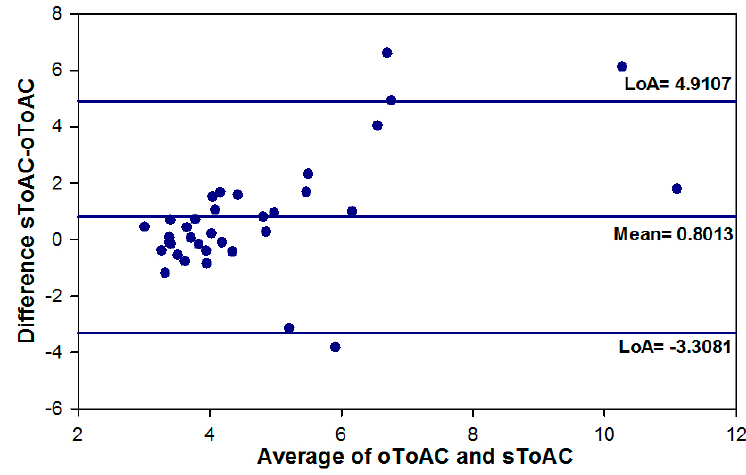
Figure 8. Bland and Altman plot of Subjective Time for Accommodative Change and Objective Time for Accommodative Change.